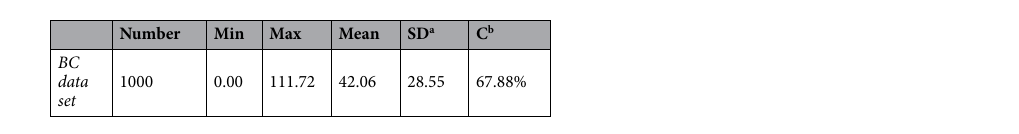
Table 1. Summary statistics of BC incidence (per 100,000 cases). a Standard deviation. b Coefficient of